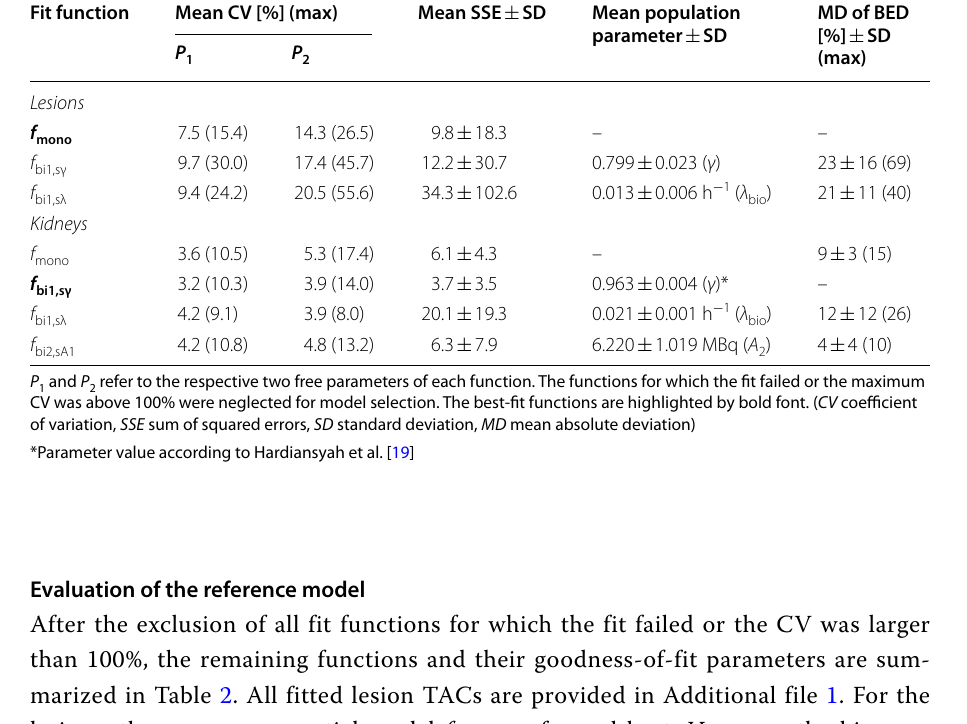
Table 2 Summary of the goodness-of-fit parameters and the shared population-based parameters for the evaluated lesion and kidney fit functions